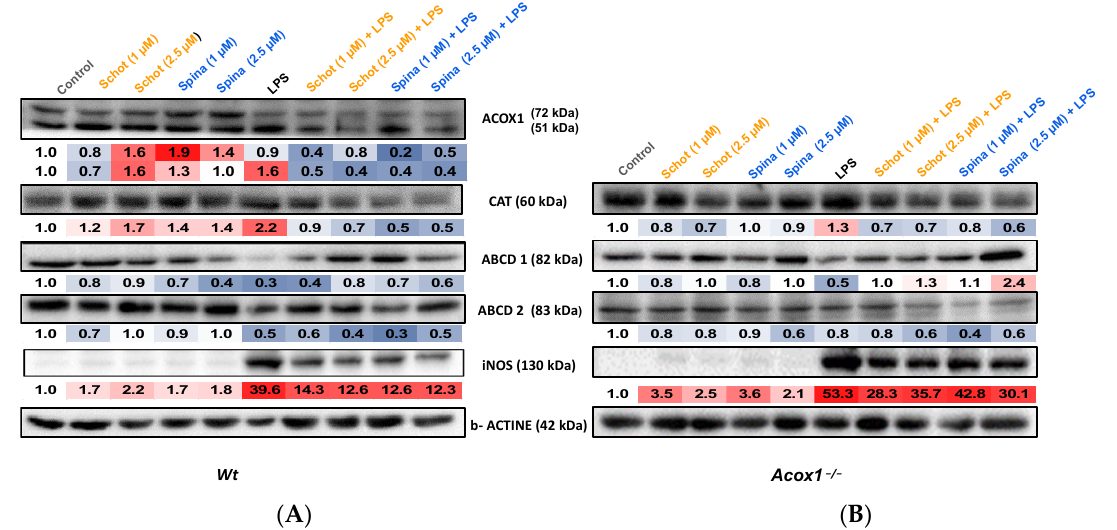
Figure 6. Immunoblotting assay showing effects of Schot and Spina on the expression of the perox- isomal proteins ACOX1, CAT, ABCD1, and ABCD2 and the inflammatory marker iNOS in Wt ( A ) and Acox1 − / − ( B ) BV-2 microglial cells. Cells were incubated for 24 h with Schot or Spina (1 or 2.5 µM) in the absence or presence of LPS (1 µg/mL). Cell homogenates were analyzed by PAGE-SDS electrophoresis and subjected to immunoblotting. Band intensities were analyzed by densitometry and standardized to β -actin expression level. Table values represent standardized densitometric analysis obtained after the signal intensity quantification of different proteins.